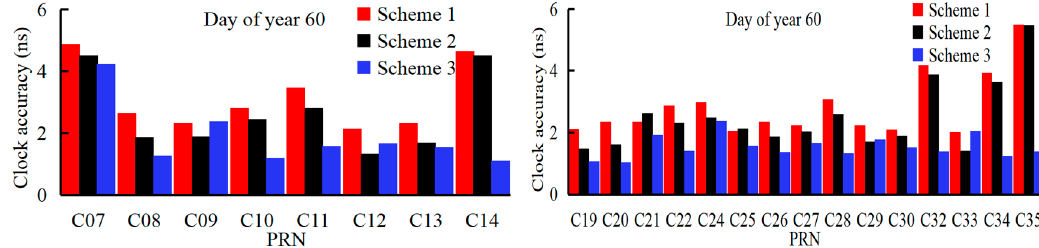
Figure 5. Daily accuracy of the clock offsets of BDS-2 ( left ) and BDS-3 ( right ) obtained from three schemes on DOY 60. Table 2. The average daily accuracy of the clock offsets resulting from the three schemes and corresponding improvements.